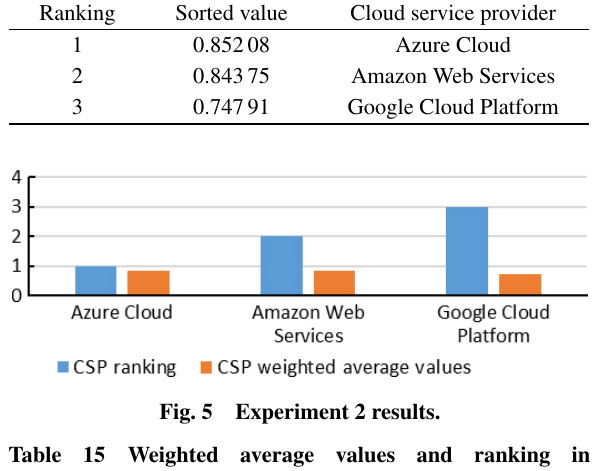
Fig. 4 Experiment 1 results. Table 14 Weighted average values and ranking in Experiment 2.